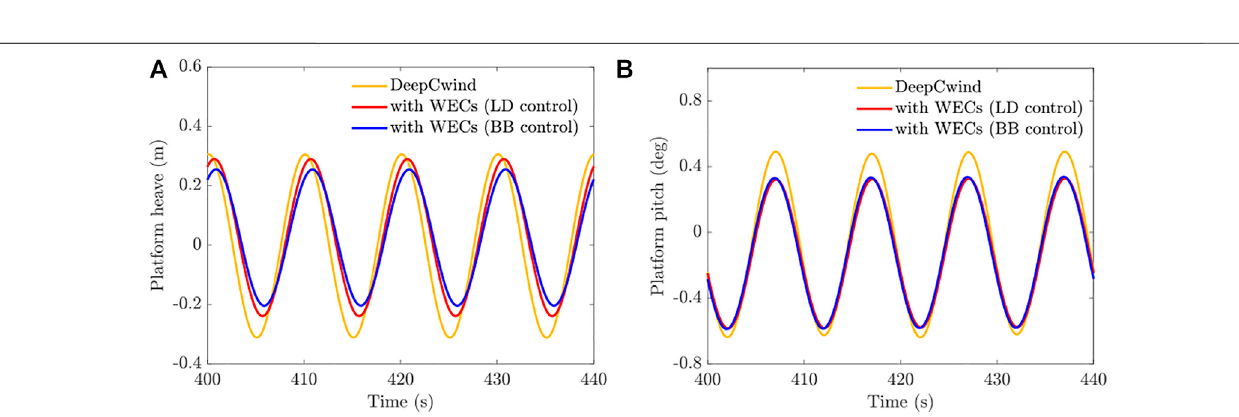
FIGURE 9 | Comparisons of platform motions with different PTO control